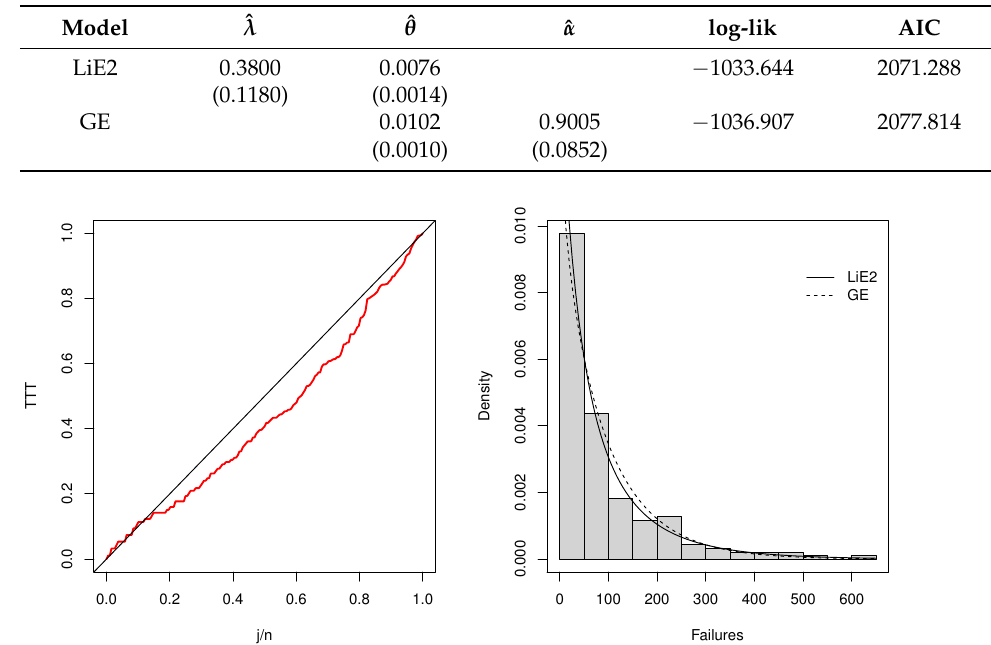
Figure 11. TTT plot of the data set (on the left ) and two competing fits for the Failure data (on the right